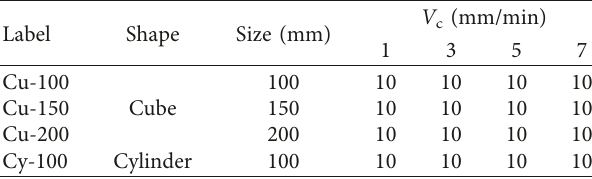
Table 2: Mechanical properties of CEB.